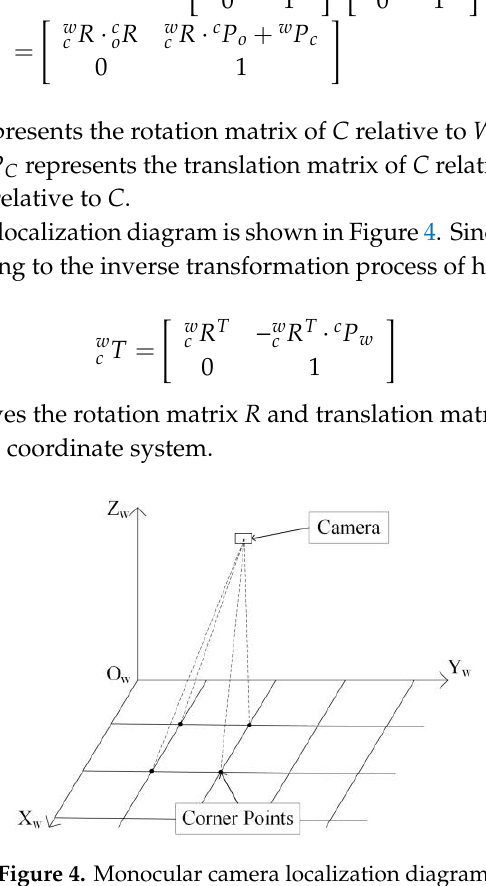
Figure 4. Monocular camera localization diagram.